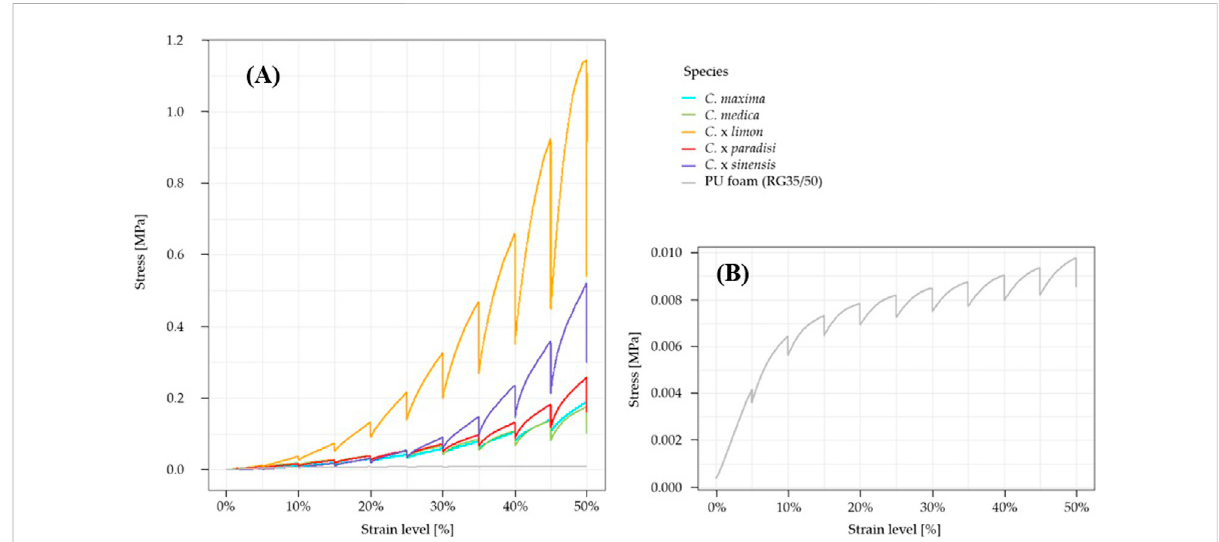
FIGURE 3 Characteristic stress-strain diagrams (A) for a specimen of each tested citrus species: pomelo ( C. maxima ), citron ( C. medica ), lemon ( C. x limon ),grapefruit( C. x paradisi ),orange( C. x sinensis ),andPUfoam(RG35/50) (B) Zoomedillustrationofacharacteristicstress-straindiagramofthe PU foam